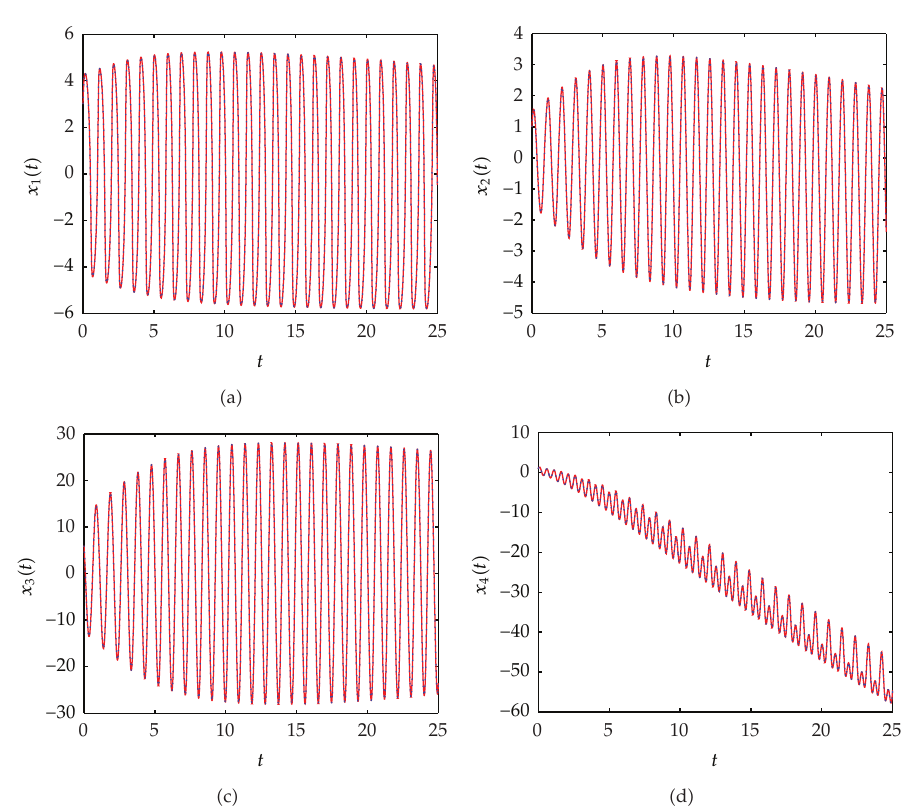
Figure 1: Comparison between the MSRM (cid:2) solid line (cid:3) and ode45 (cid:2) dots (cid:3) solution of the hyperchaotic Chua